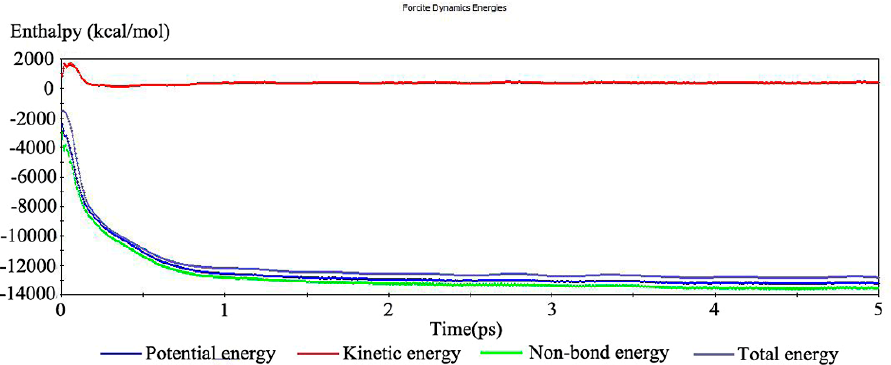
Figure 6. Energy change process of the CaF 2 -Al(OH) 3 suspension system.